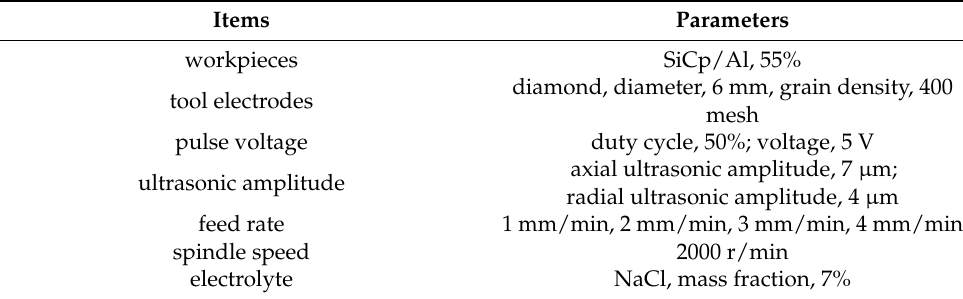
Table 3. Machining parameters with different feed